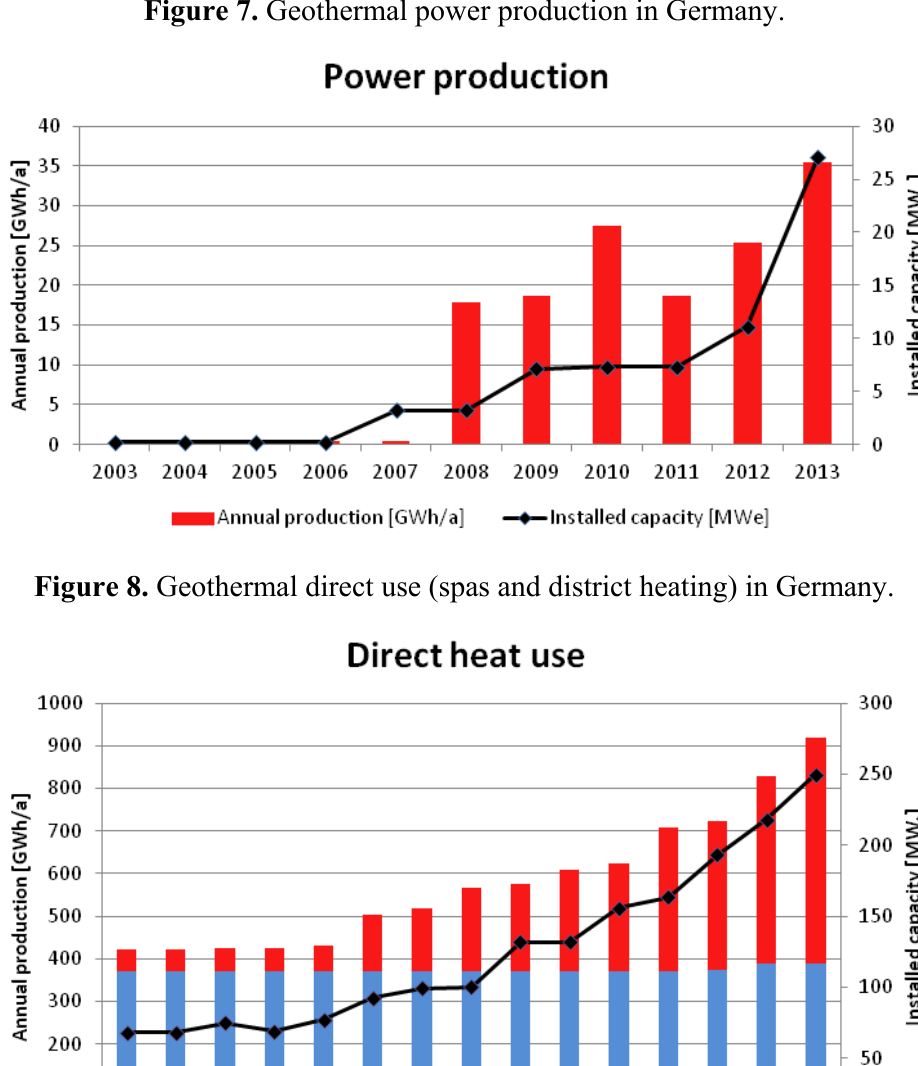
Figure 7. Geothermal power production in Germany.